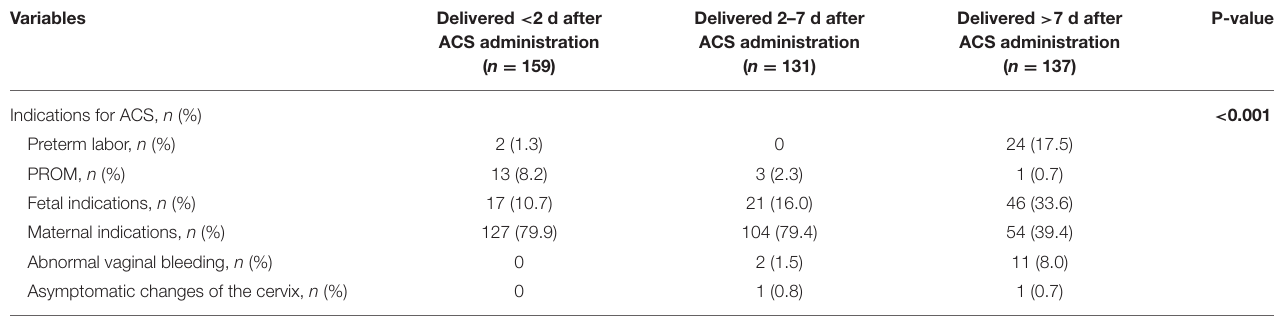
TABLE 2 | Comparison of indications for antenatal corticosteroids administration among